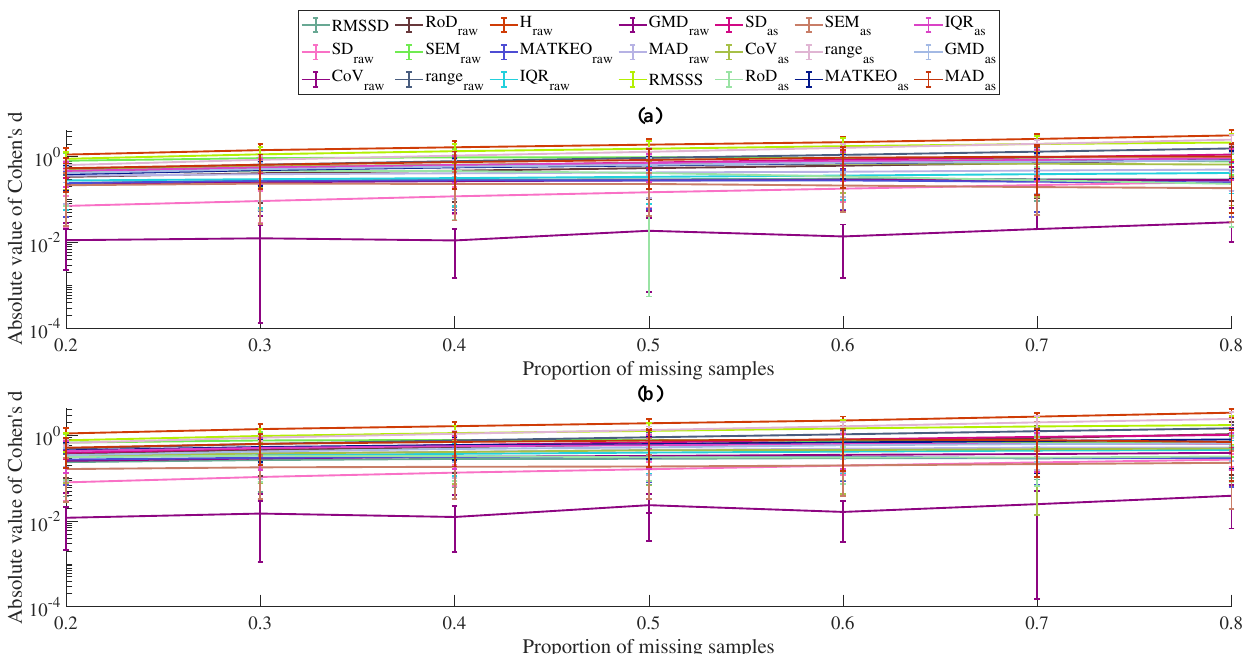
Figure 6. Performance degradation in real data for questions: ( a ) “Today I feel the wish to live.” ( b ) “Today I feel tired during the day because of my sleep